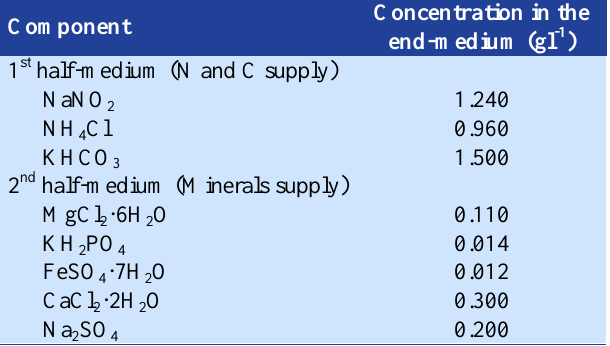
Table 1. Enrichment medium composition